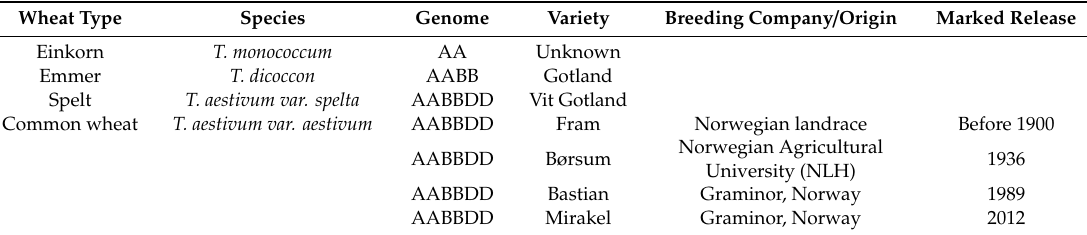
Table 1. Genomic asset and origin of the wheat types